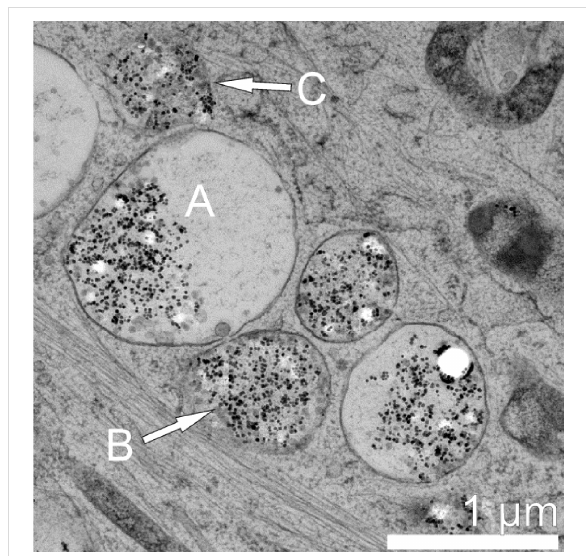
Figure 6: TEM bright field micrograph of a MSC after 24 h of incuba- tion. The appearance of the PLLA containing endosome is quite different from those presented in Figure 4. Large endosomes filled with many magnetite and PLLA particles can be observed.